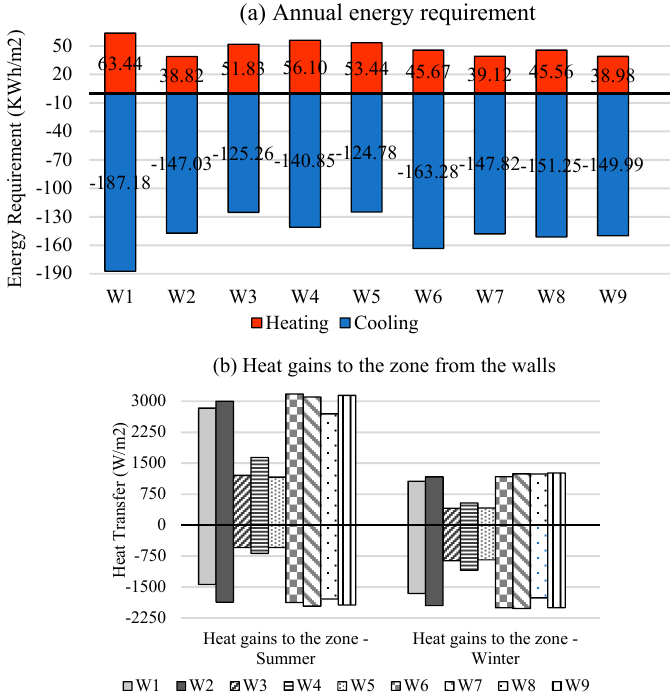
Figure 9. Annual Energy requirement ( a ) and heat gains ( b ) for different wall configurations.